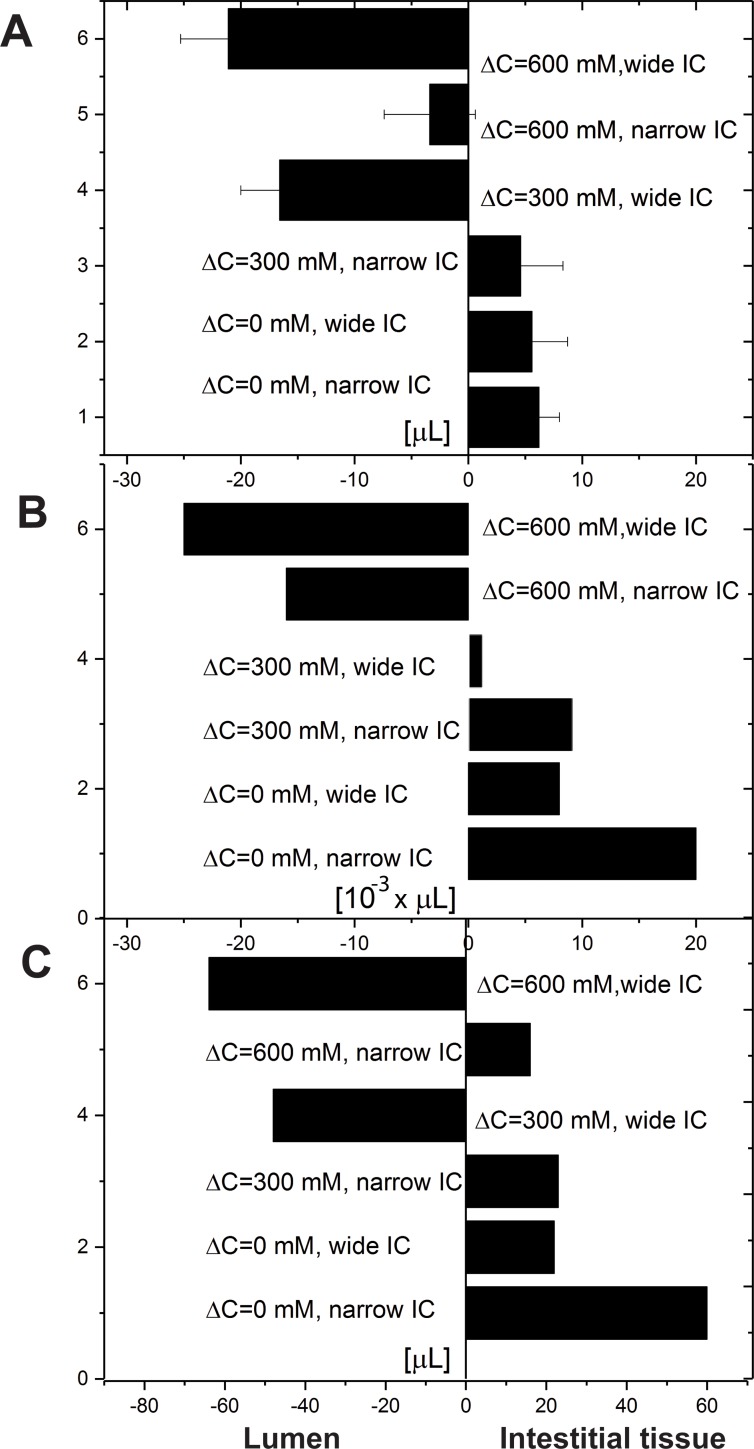
Change in water volume per hour for strong, medium hypertonic, and isotonic osmolarities in the lumen.Osmolarity difference between lumen and interstitial (Δc = c1−c4) is accordingly 600, 300, and 0 mM. The results are presented for wide (b = 400 nm) and narrow (b = 40 nm) clefts. (A) Experimentally measured fluxes, as the peptide disrupts LI cadherins binding (the IC widening as shown in Fig 1B with low osmolarity). The figure is adapted from [12]; (B) Water flux change through the TJ, numerical results; (C) Water flux through the open end of the IC as a result of elevated cytosolic concentration c3. Changes in response to the alteration of lumen osmolarity: 900mM, 600mM and 300mM. The following system parameters were used: c4 = 300 mM,L = 20 μm.